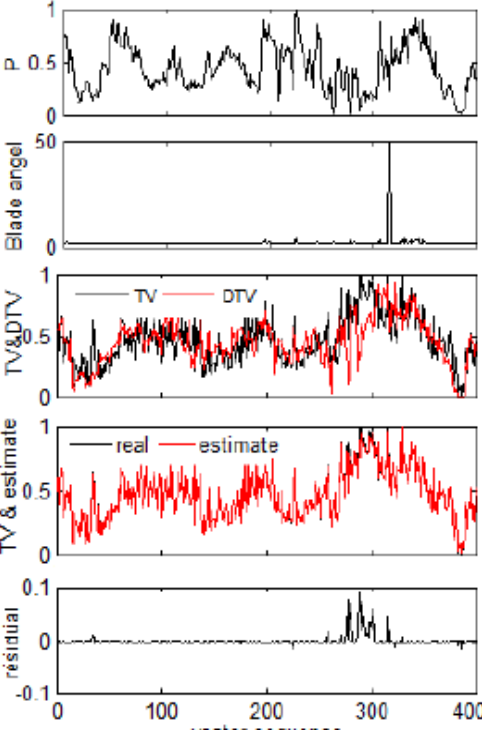
Figure 6. Trends for blade angle